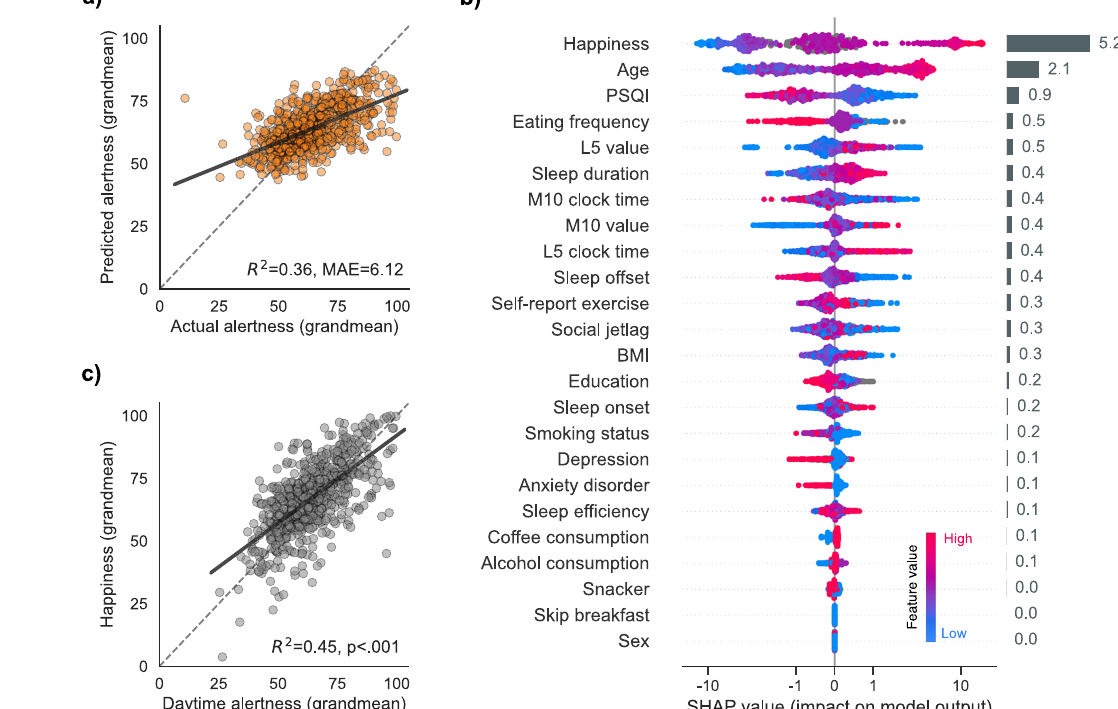
for each participant, the exact contribution of a given feature on the output of the model.Thecolourofthedotsrepresentsthevalueofagivenpredictorfromlowto high(e.g.forage,younger=blue,older=pink).Globalfeatureimportanceisshown in the rightmost horizontalgrey bars and was calculated byaveraging the absolute Shapley values of a given predictor across all participants. c Trait correlation betweenhappinessandalertness.Happinesswasthemostimportantfeatureofthe model. Higher trait happiness is associated with higher trait alertness. Source data are provided as a Source Data fi le.